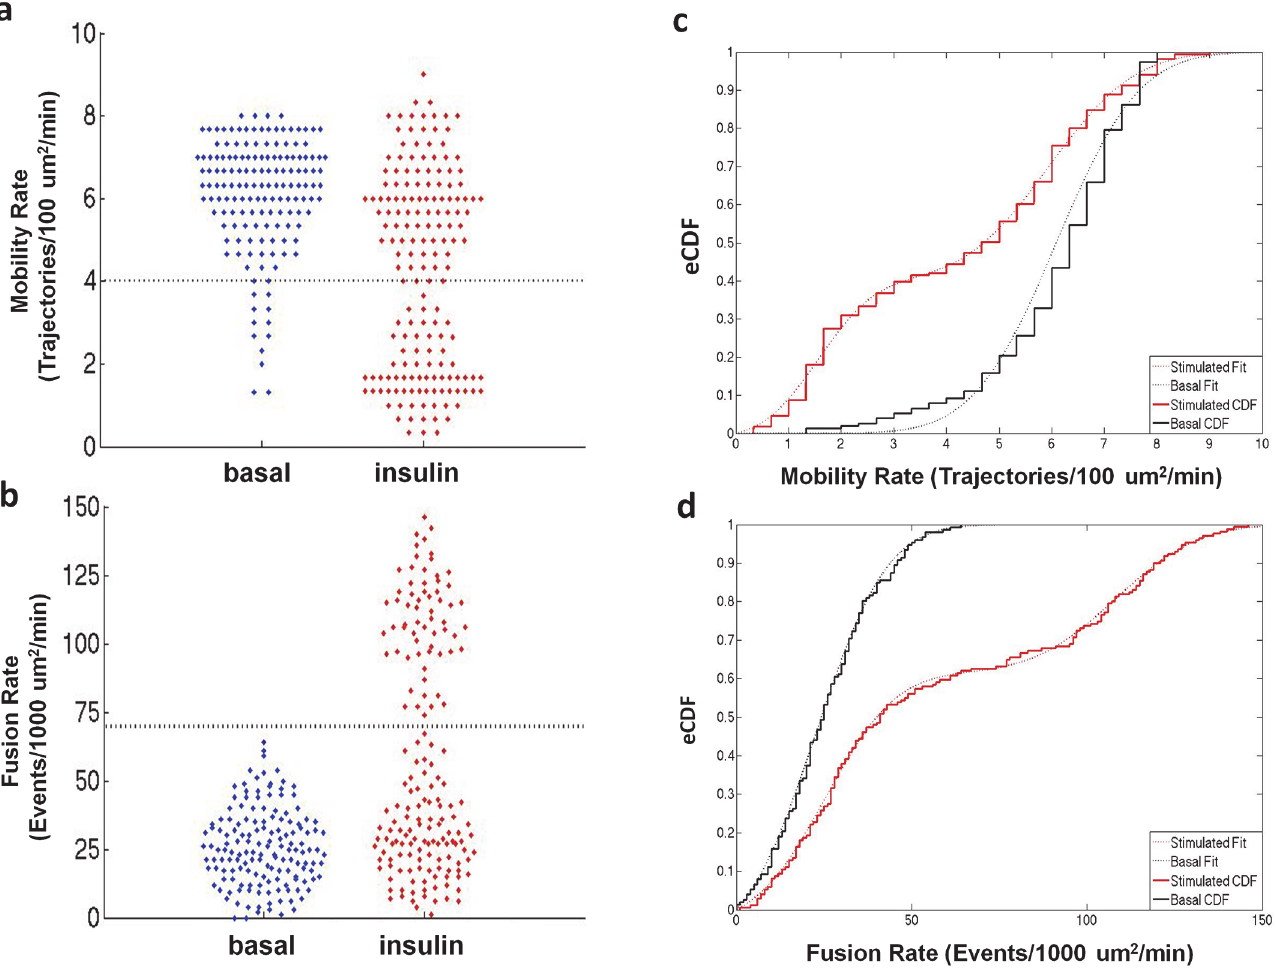
Fig 4. “ Bee swarm ” plots of single cell GSV mobility (a) and fusion (b) rates measured in the basal and insulin-stimulated states are consistent with two populations in the insulin-stimulated state in which one population matches the basal state. The “ bee swarm ” plots were created using the plotSpread function (by Jonas) and the cluster boundaries were calculated using the K-means clustering function, both within the program MATLAB. Cumulative distributions calculated for GSV mobility (c) and fusion (d) rates pooled from basal (black) and insulin stimulated (red) cells from all subjects. Basal CDFs were described by a single zero-truncated Gaussian cumulative distribution, while both CDFs for insulin stimulated mobility and fusion data were characterized by the sum of two zero-truncated Gaussian cumulative